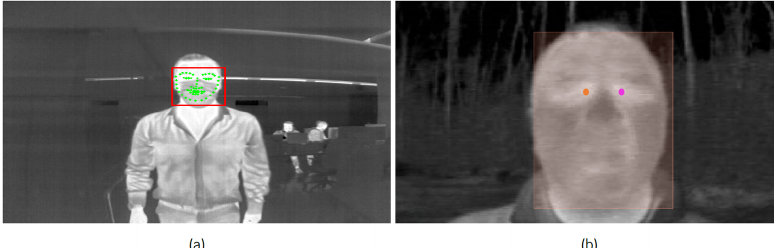
Figure 7. Examples of samples where semiautomatic label technique was applied. ( a ) Automatic Labeling. Red rectangle refers to bounding box of identified face, and green dots to respective facial marks. ( b ) Manual labeling. Orange rectangle is associated to identified face, while orange and violet dots refer, respectively, to points that identify right- and left-caruncles.